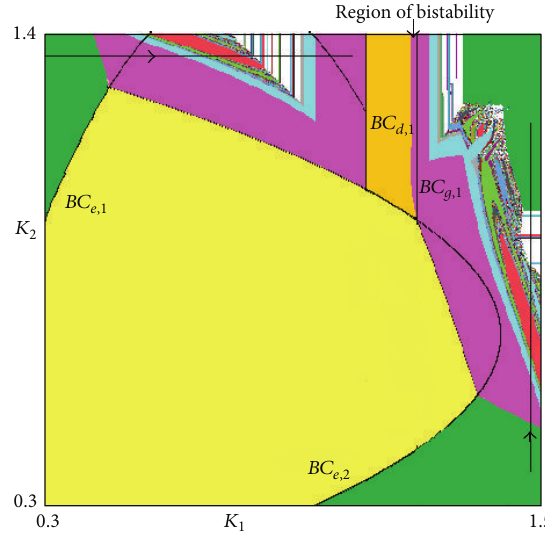
Figure 2: Two-dimensional bifurcation diagram on the (𝐾 1 , 𝐾 2 ) - parameter plane for map 𝑇 at 𝑁 1 = 1.5 , 𝑁 2 = 1.4 , 𝜏 1 = 𝜏 2 = 4 , and 𝛾 1 = 𝛾 2 = 1 . Different colors are related to attracting cycles of different periods 𝑛 ≤ 30 ; the white region corresponds either to chaotic attractors or to cycles of higher periods. In particular, the dark-green regions represent the set of values at which the equilibria of segregation are stable. For parameters in the yellow region besides the two equilibria of segregation there exists also the superstable fixed point (𝐾 1 , 𝐾 2 ) . For parameters in the orange region, (𝐾 1 , 𝑥 ∗ 2,𝑏 ) is a stable fixed point, coexisting with the two stable equilibria of